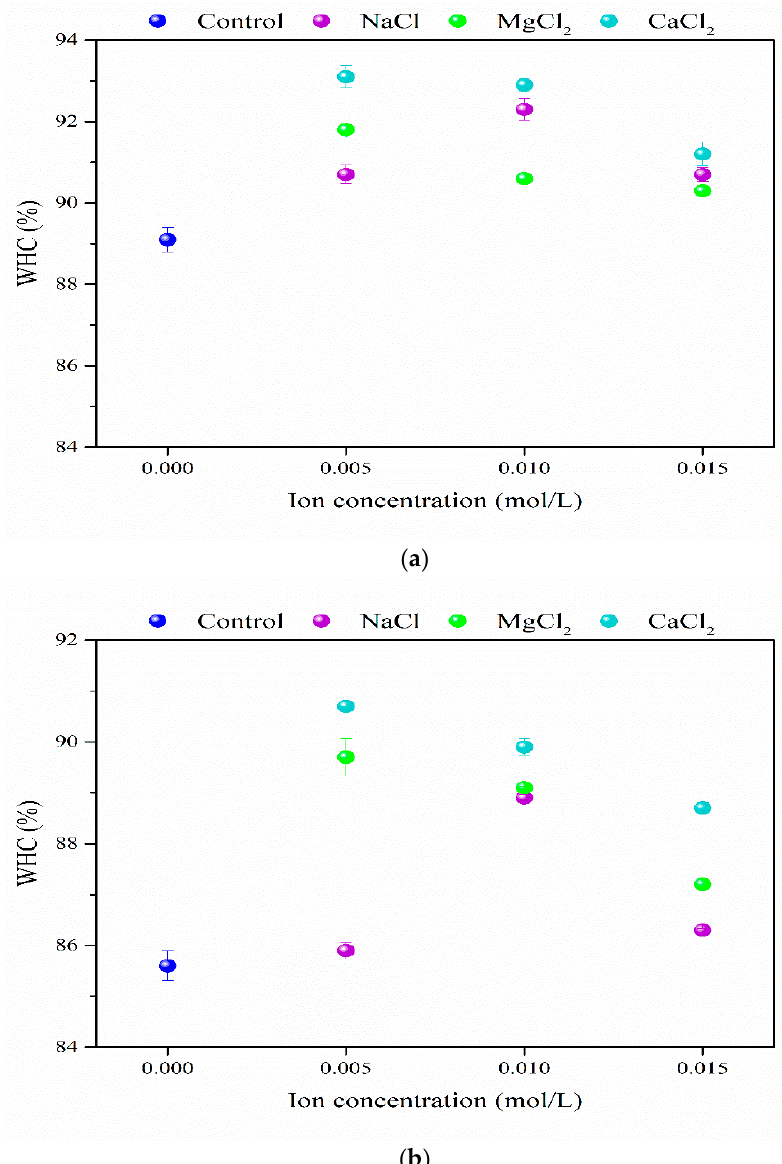
Figure 4. Effect of salt ion addition before spray drying on the gel water holding capacity (WHC) of soy protein isolate: ( a ) heat-induced gels; ( b ) cold-induced gels. soy protein isolate: ( a ) heat-induced gels; ( b ) cold-induced